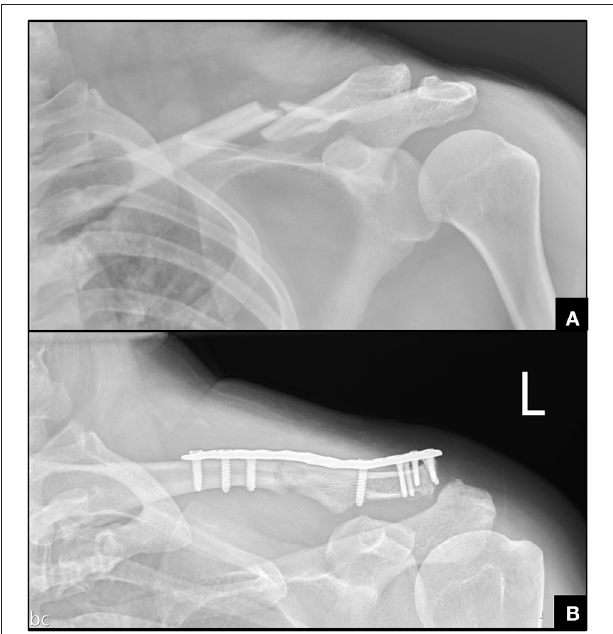
FIGURE 1 | Radiography for the clavicle fracture. (A) Left middle-third clavicle fracture. (B) Postoperative radiography.